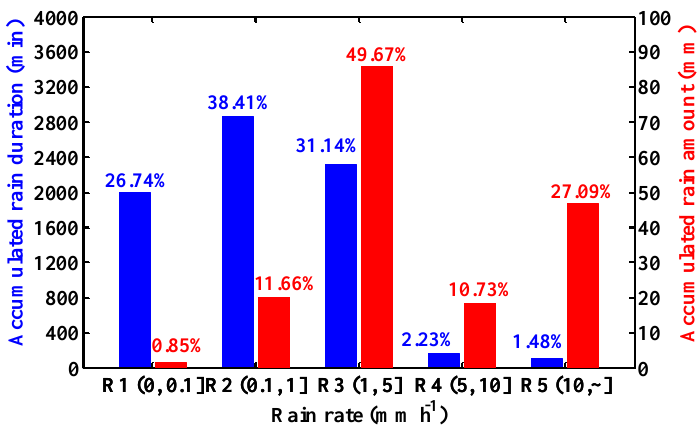
Figure 3. Accumulated durations (blue) and rain amounts (red) for the five rain-rate regimes. The percentages indicate the contributions of each rain-rate regime to the total duration and total rain amount.